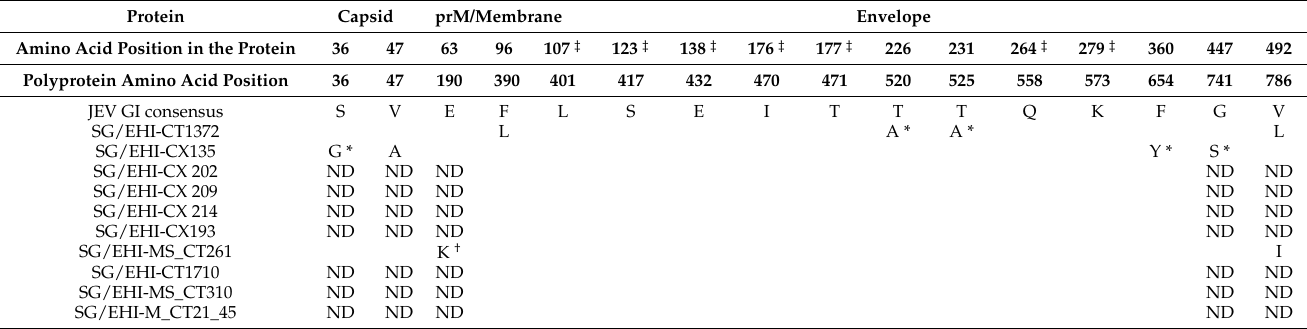
ND ND ND ND = Not determined because only partial E -gene sequences (701 bp) were analyzed for respective sequences. * Non-conservative (polar/non-polar) mutation; † Conservative mutation with charge differences. ‡ Amino acid positions in the E protein commonly associated with JEV neurovirulence and/or neuroinvasiveness